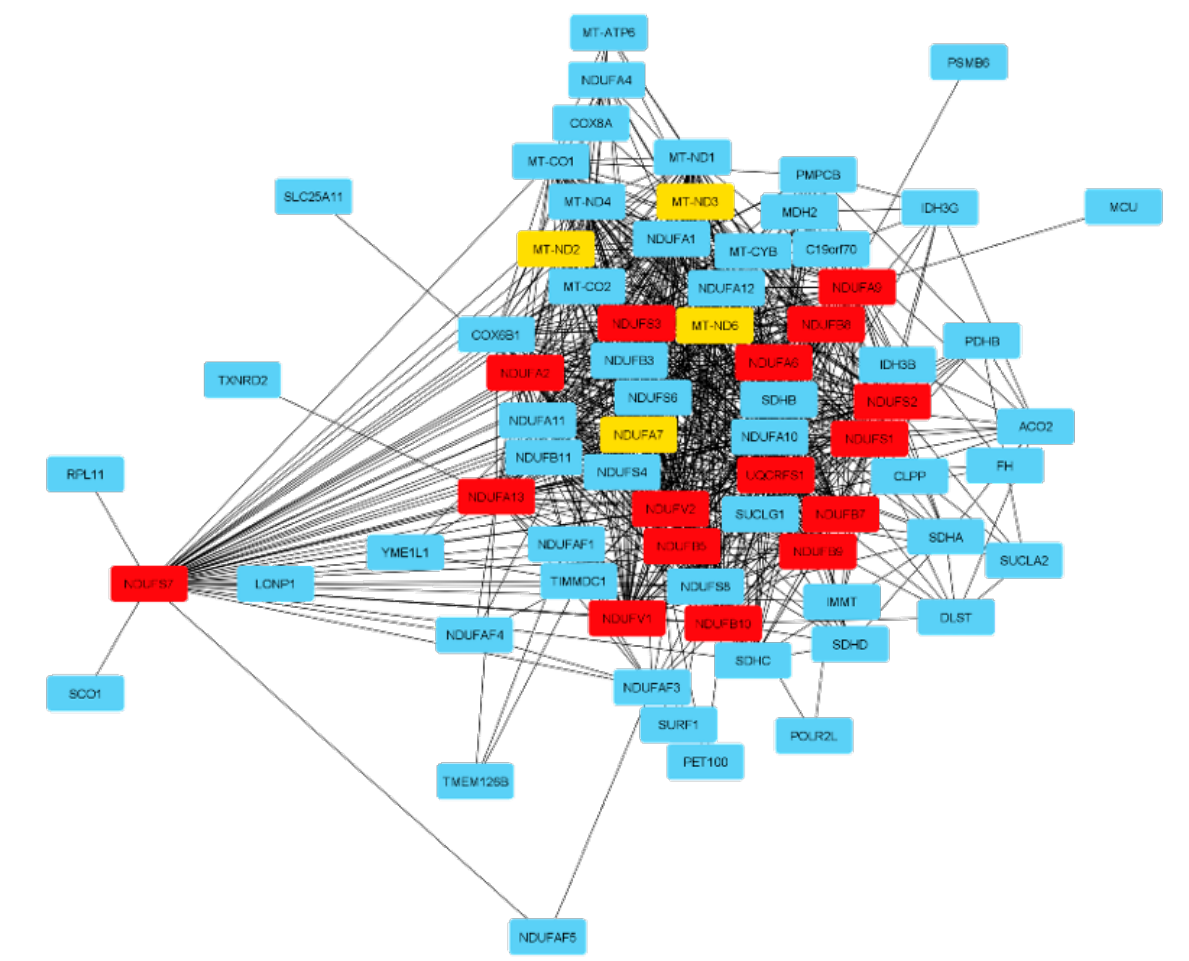
Figure 2. Hub gene network and the related expanded subnetwork. The MCC method ranks the genes with a red-yellow scale, when red genes are the most relevant in the top 20 genes in the network.